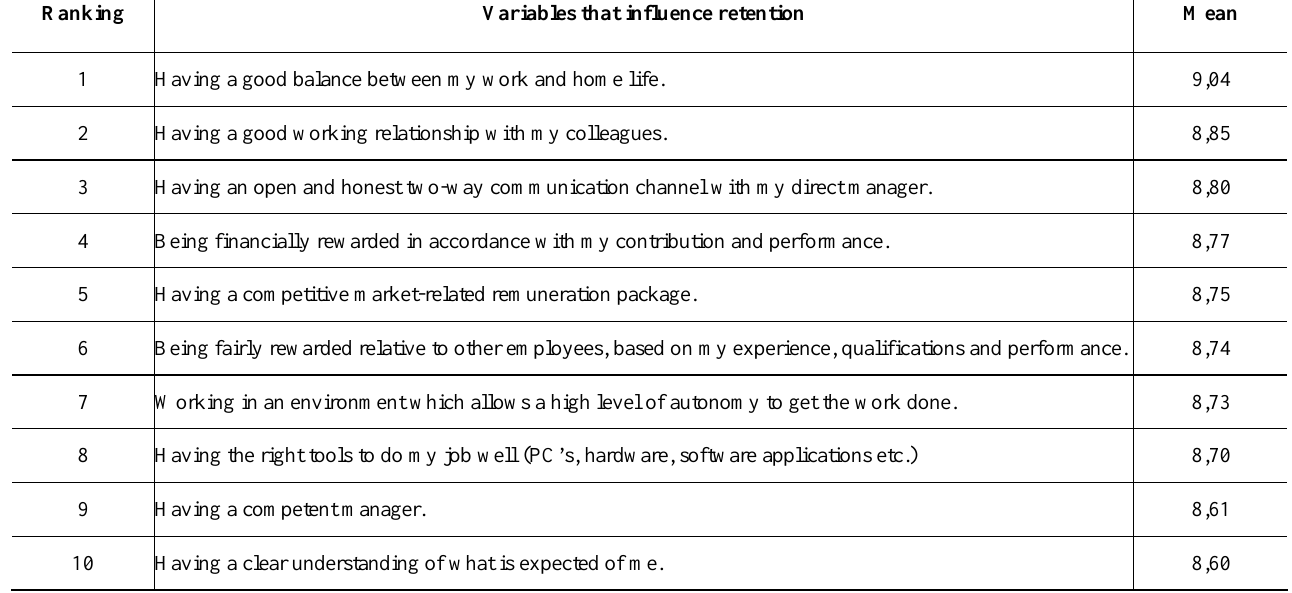
Table 1: The top ten variables Ranking Variables that influence